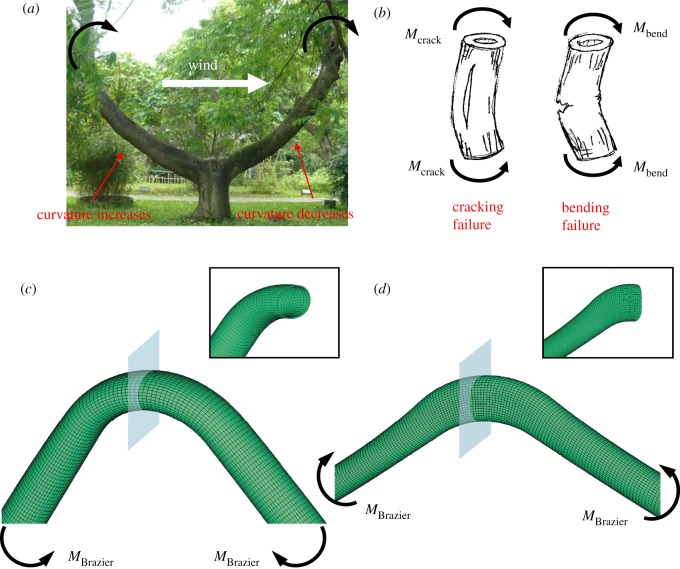
(a) An example of curved tree trunks: the outer radius R ≈ 0.2 m, the initial curvature c ≈ 0.35 m−1 and the dimensionless initial curvature cR ≈ 0.07; Trema orientailis (hardwood). Photo credit: Yan-San Huang. (b) Schematics of cracking and bending failures. (Trunk sketches by Da-Chang Yang.) (c,d) Finite-element simulations of cross-sectional flattening, known as Brazier buckling, of a curved circular hollow trunk subjected to curvature-increasing bending (c) and curvature-decreasing bending (d). The cross-section becomes ovalized with its long axis perpendicular to the plane of bending in case (c), or parallel to the plane of bending in case (d). cR = 0.2, R = 0.1 m, c = 2 m−1 and t = 0.005 m.